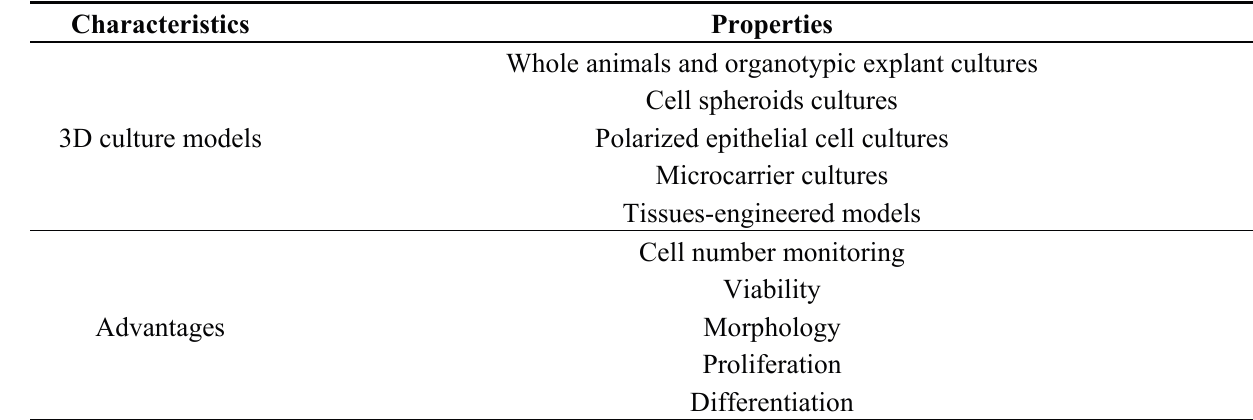
Table 1. 3D cell culture: Models, advantages and